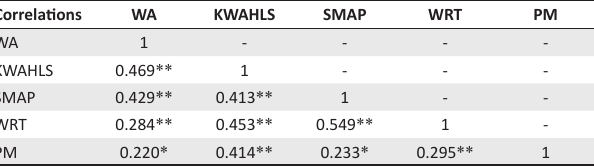
TABLE 14: Correlations matrix between